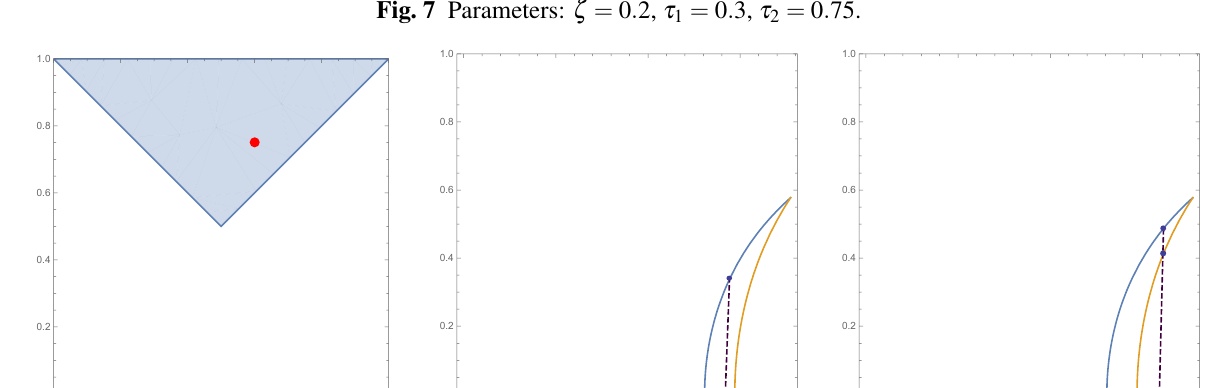
Fig. 7 Parameters: ζ = 0 . 2, τ 1 = 0 . 3, τ 2 = 0 . 75.